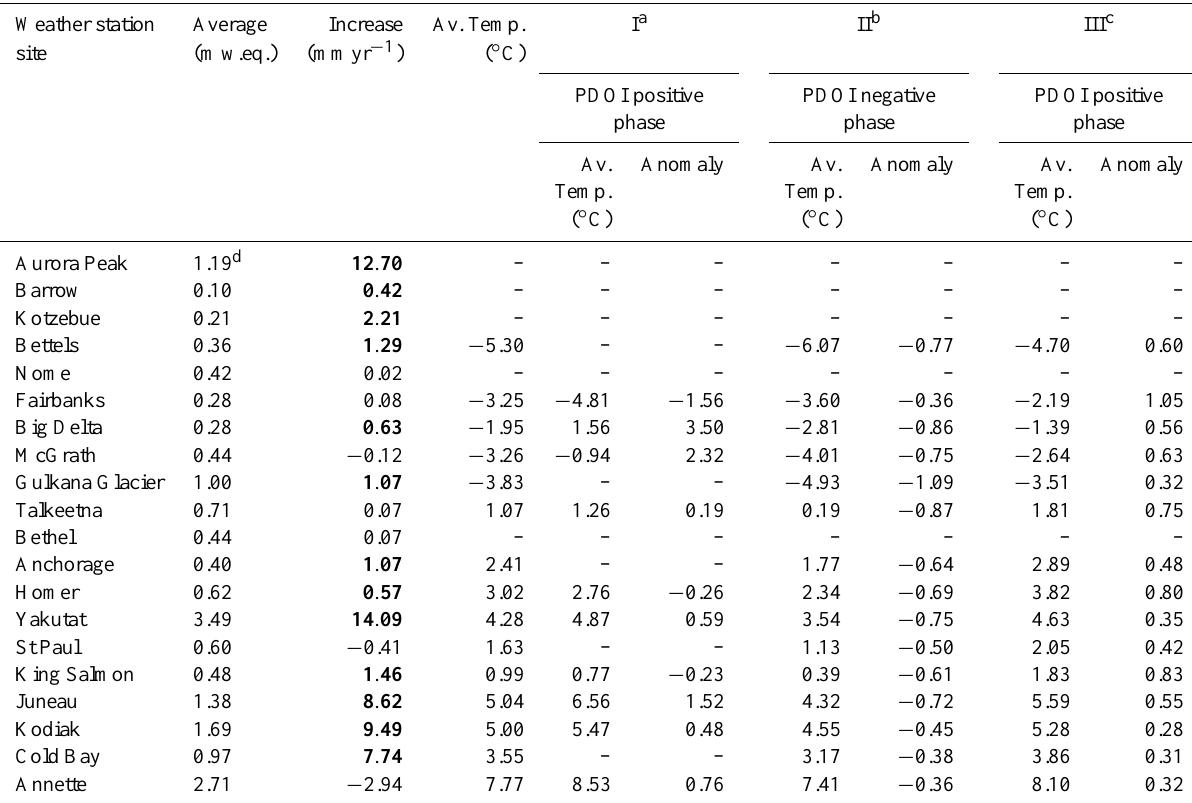
Table 3. Increase in the annual accumulation rate of Aurora Peak and annual precipitation amounts observed at weather stations after 1900. Bold numbers indicate sites which had increases of annual accumulation rate and precipitation amounts. Also shown are air temperature records at 15 weather stations during periods I, II, and III, which were correlated with the δ D of Aurora Peak ( R < 0 . 50, p < 0 . 05).